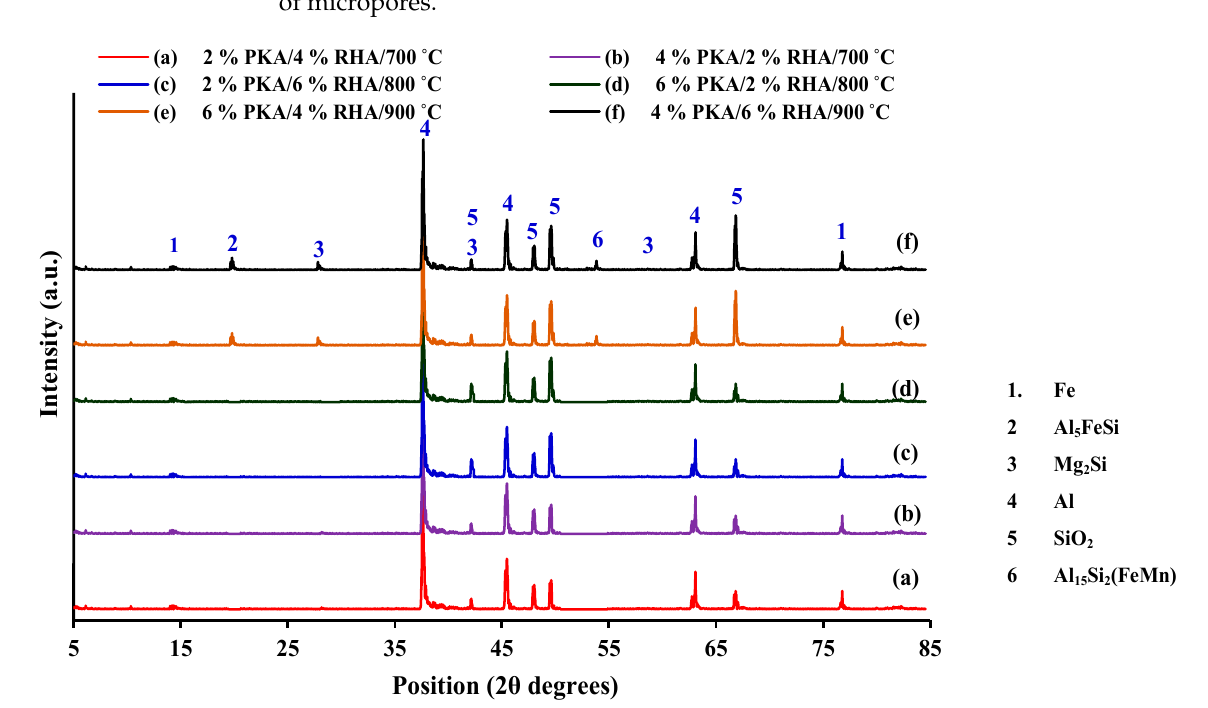
Figure 3. X-ray diffraction of selected composites.